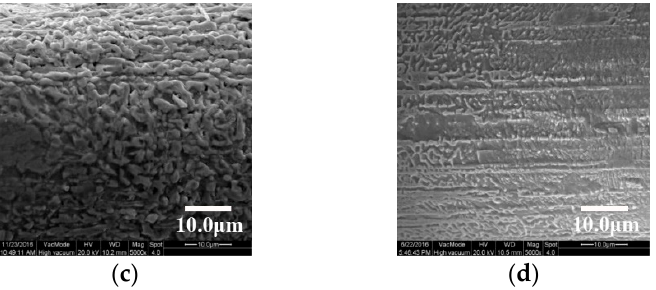
Figure 3. Copper mesh morphology after etching and oxidation under microscope and SEM: ( a , c ) unground; ( b , d ) ground.